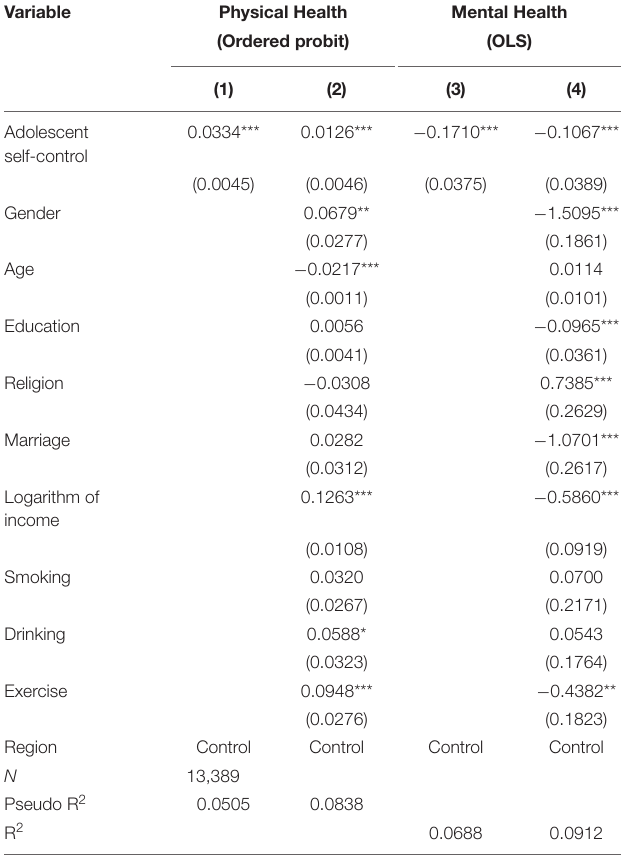
TABLE 2 | Effects of adolescent self-control on physical and mental health in adulthood.